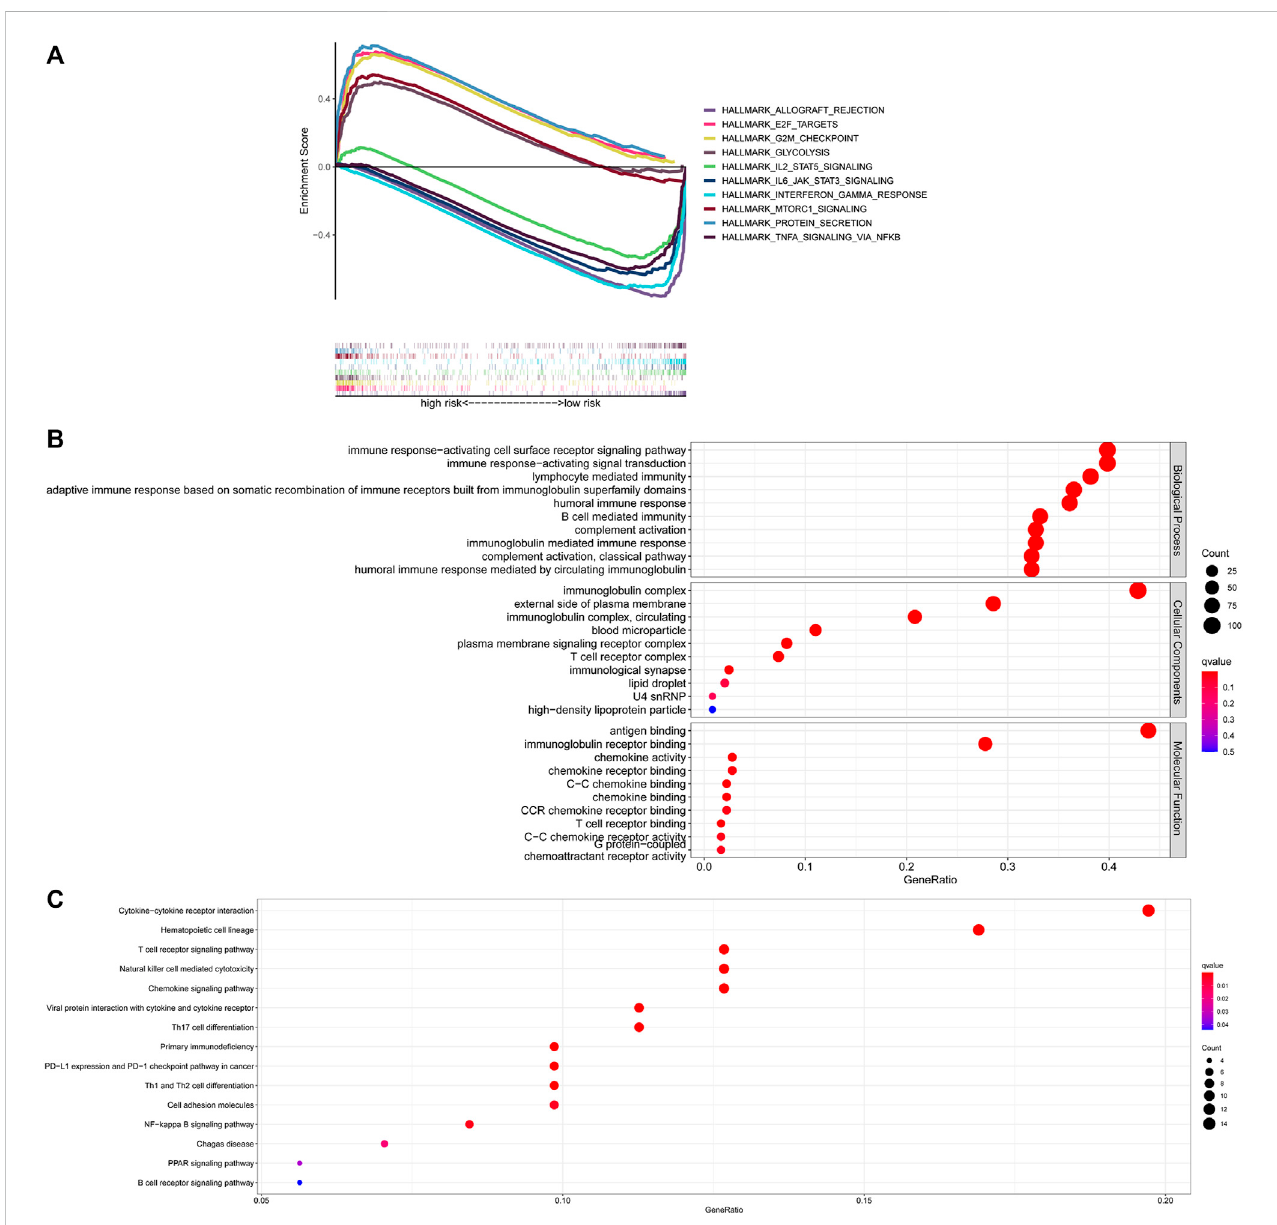
FIGURE 6 Exploration of the possible functions and pathways of NETs-related lncRNAs. (A) Tumor hallmarks in high- and low-risk subgroups. (B) GO analysis of different expression gene sets between different risk subgroups. (C) KEGG analysis of different expression gene sets between different risk subgroups. NETs, neutrophil extracellular traps; lncRNAs, long non-coding